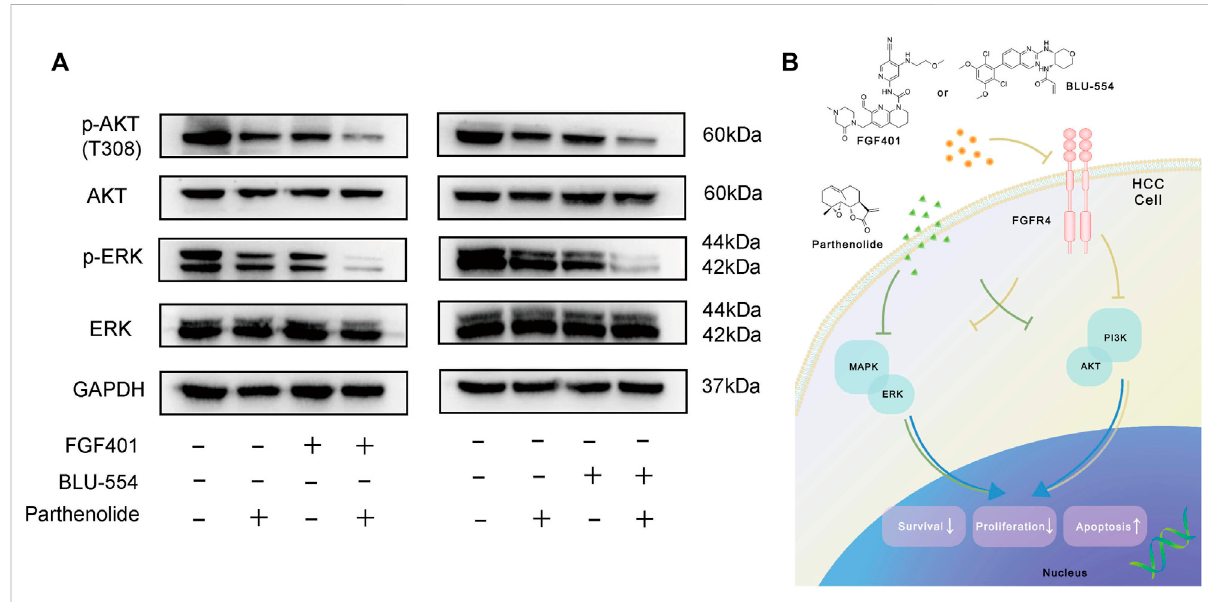
FIGURE 7 Mechanism explorationof combined schemes. (A) WBassay wasused to examine themechanism ofthecombined schemes, Huh-7cells were treated with drugs for 12 h. (B) The mechanism pathway model diagram of the combination drug